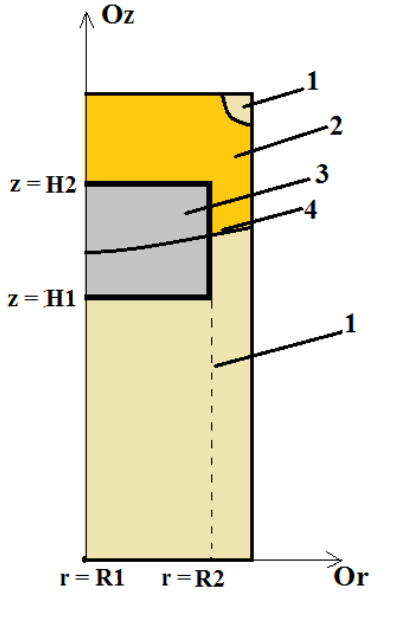
= 0; 1 , R ] × [ H , H ] 1 2 1 2